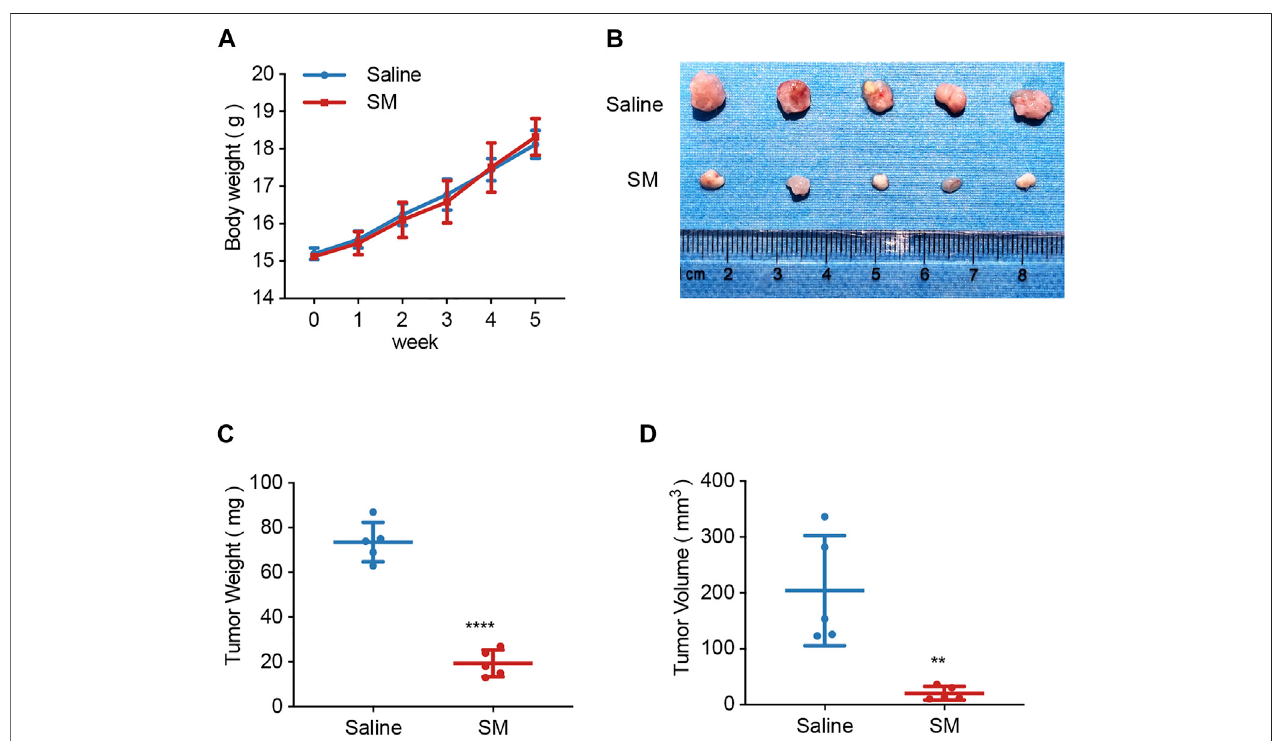
FIGURE 6 | SM inhibits FaDU xenograft tumor development in vivo . (A) Mice in the SM group were injected with SM (10 mg/kg, i. v.) once daily, and the mice that were injected with saline served as controls. The body weights of the mice were recorded weekly. After 5 weeks, tumors were separated, and their volume and weight were recorded. (B) Xenograft tumor morphology of the saline group and SM group. (C) Tumor weight of the saline group and SM group. (D) Tumor volume of the saline group and SM group. **( p < 0.01) and ****( p < 0.0001) indicate statistically signi fi cant